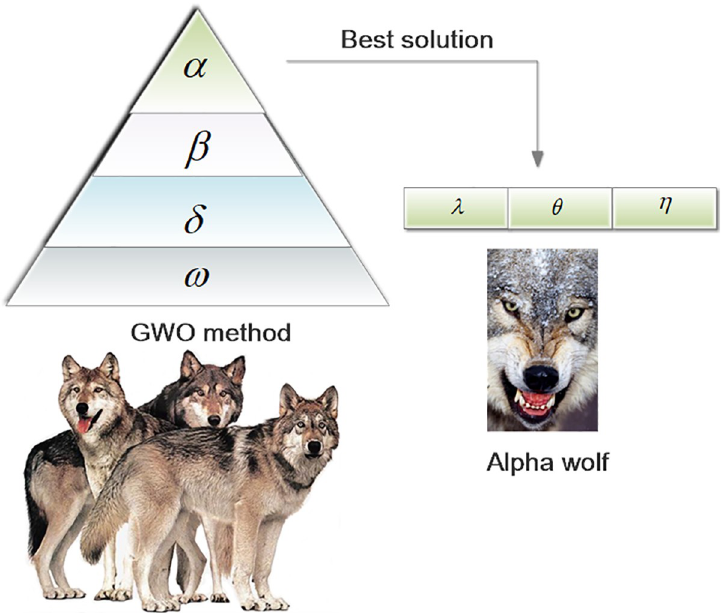
Fig 10. The relationship between the GWO and loss function